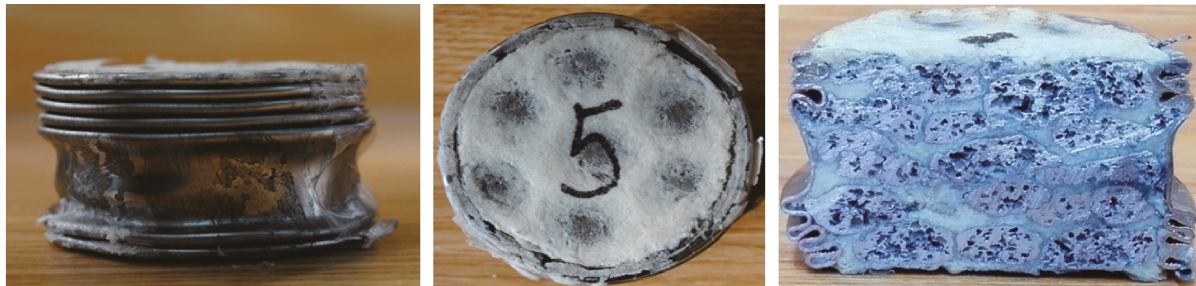
Figure 8: Final morphology of epoxy foam-bonding APM composite pipes after deformation.